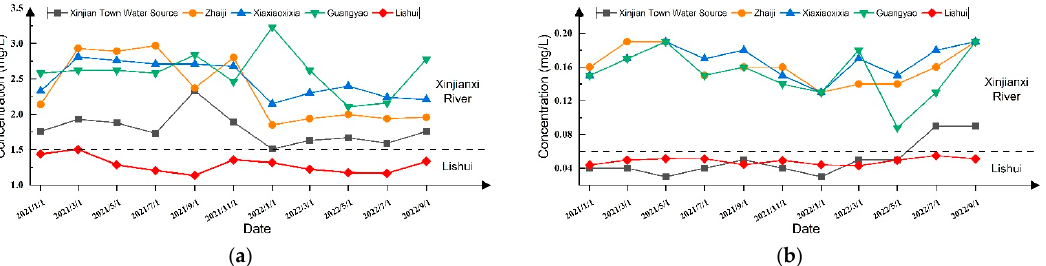
Figure 4. Variation of TN and TP concentrations in the Xinjian River. ( a ) shows the average concentration of TN in Lishui City is much lower than that in Xijianxi River, even for the upstream water source. ( b ) shows the TP concentration in upstream water source is comparable to Lishui average condition, which is much lower than midstream and